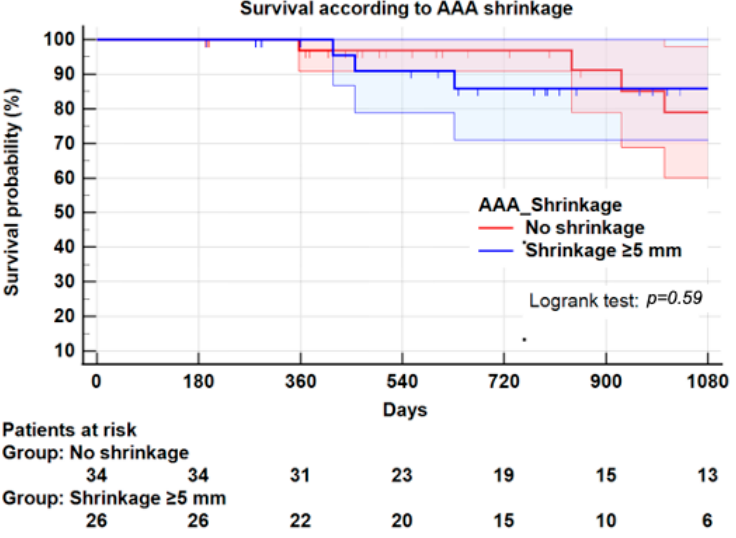
Figure 6. Kaplan–Meier plot for survival according to sac shrinkage. At 3 years, survival was 85.9 ± 7.0% in patients with sac shrinkage and 79.0 ± 9.0% in patients without sac shrinkage, p = 0.59.